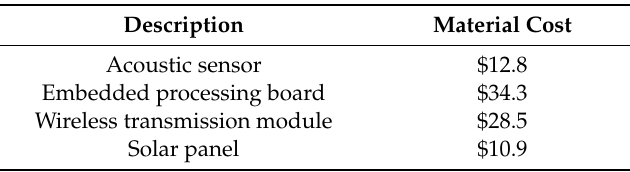
Table 1. The cost of each sensor